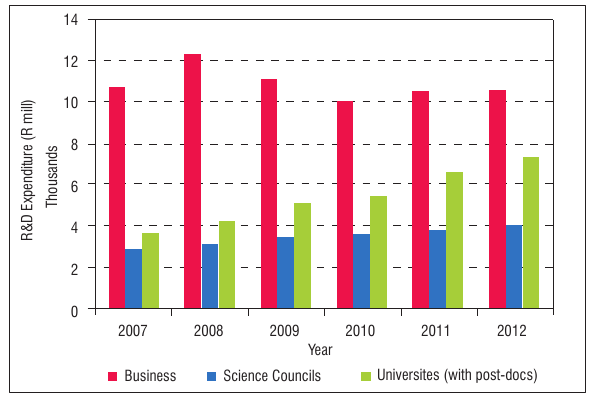
R&D performance by business, science and universities (2007 to